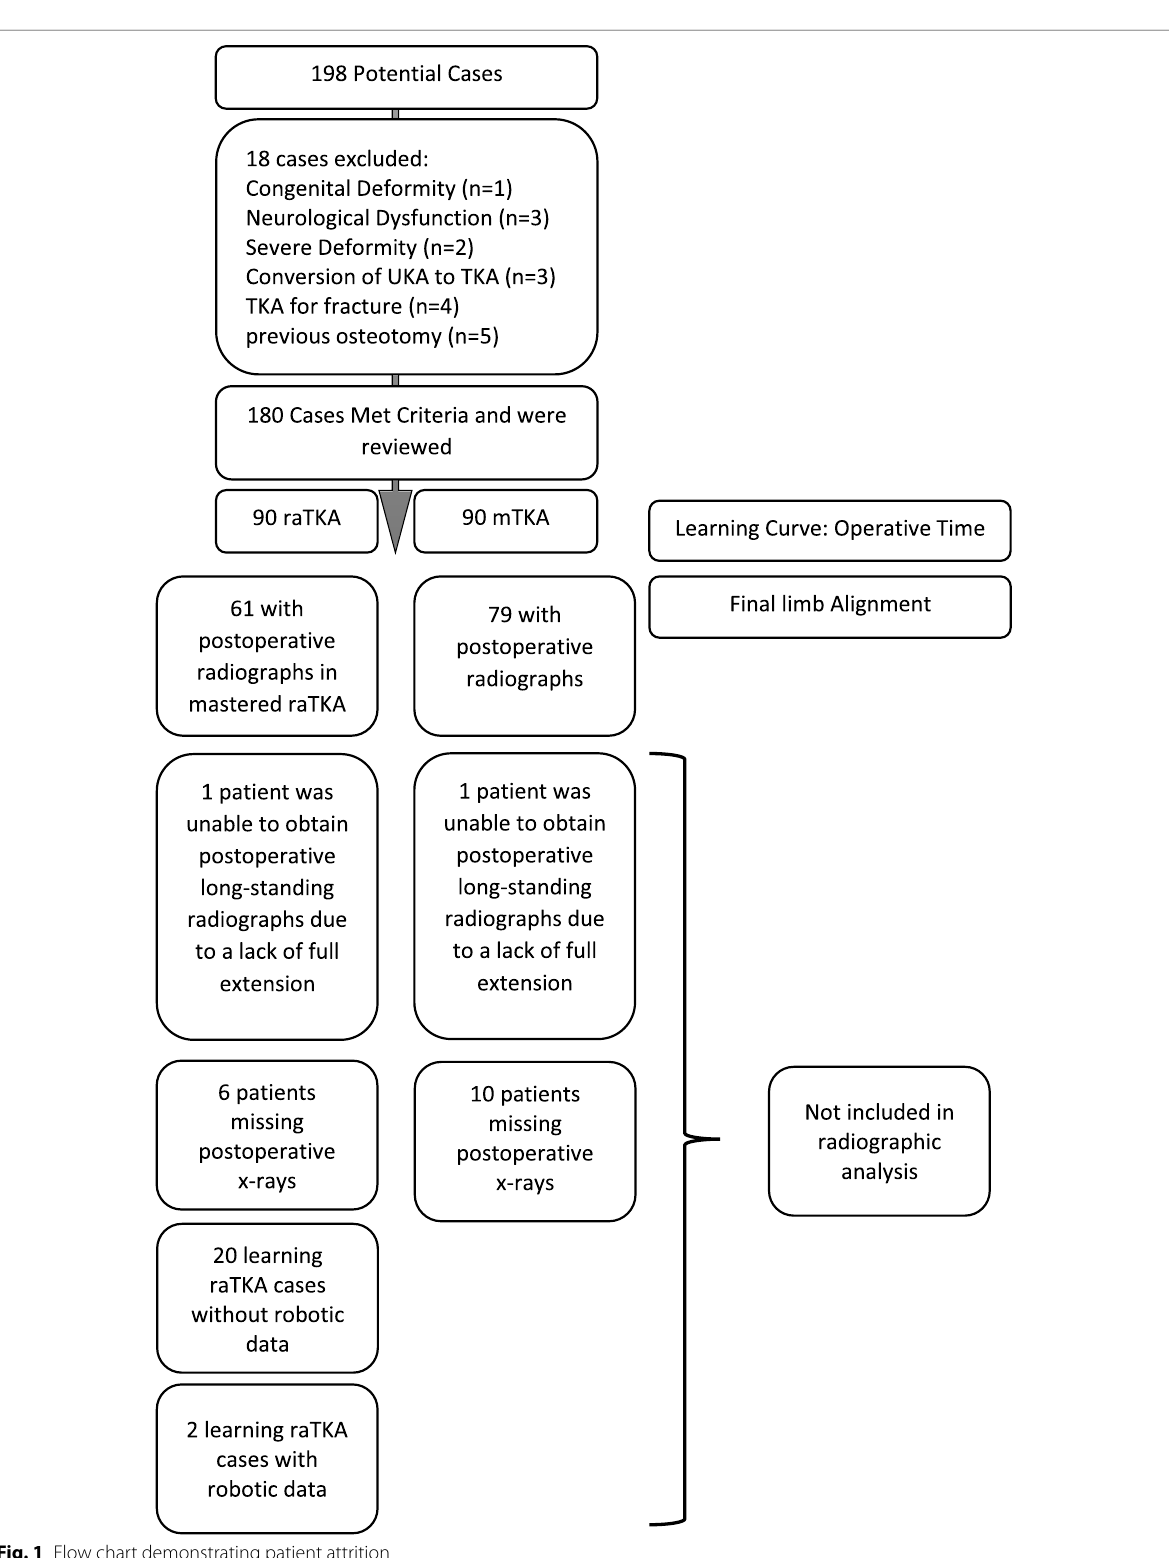
Fig. 1 Flow chart demonstrating patient